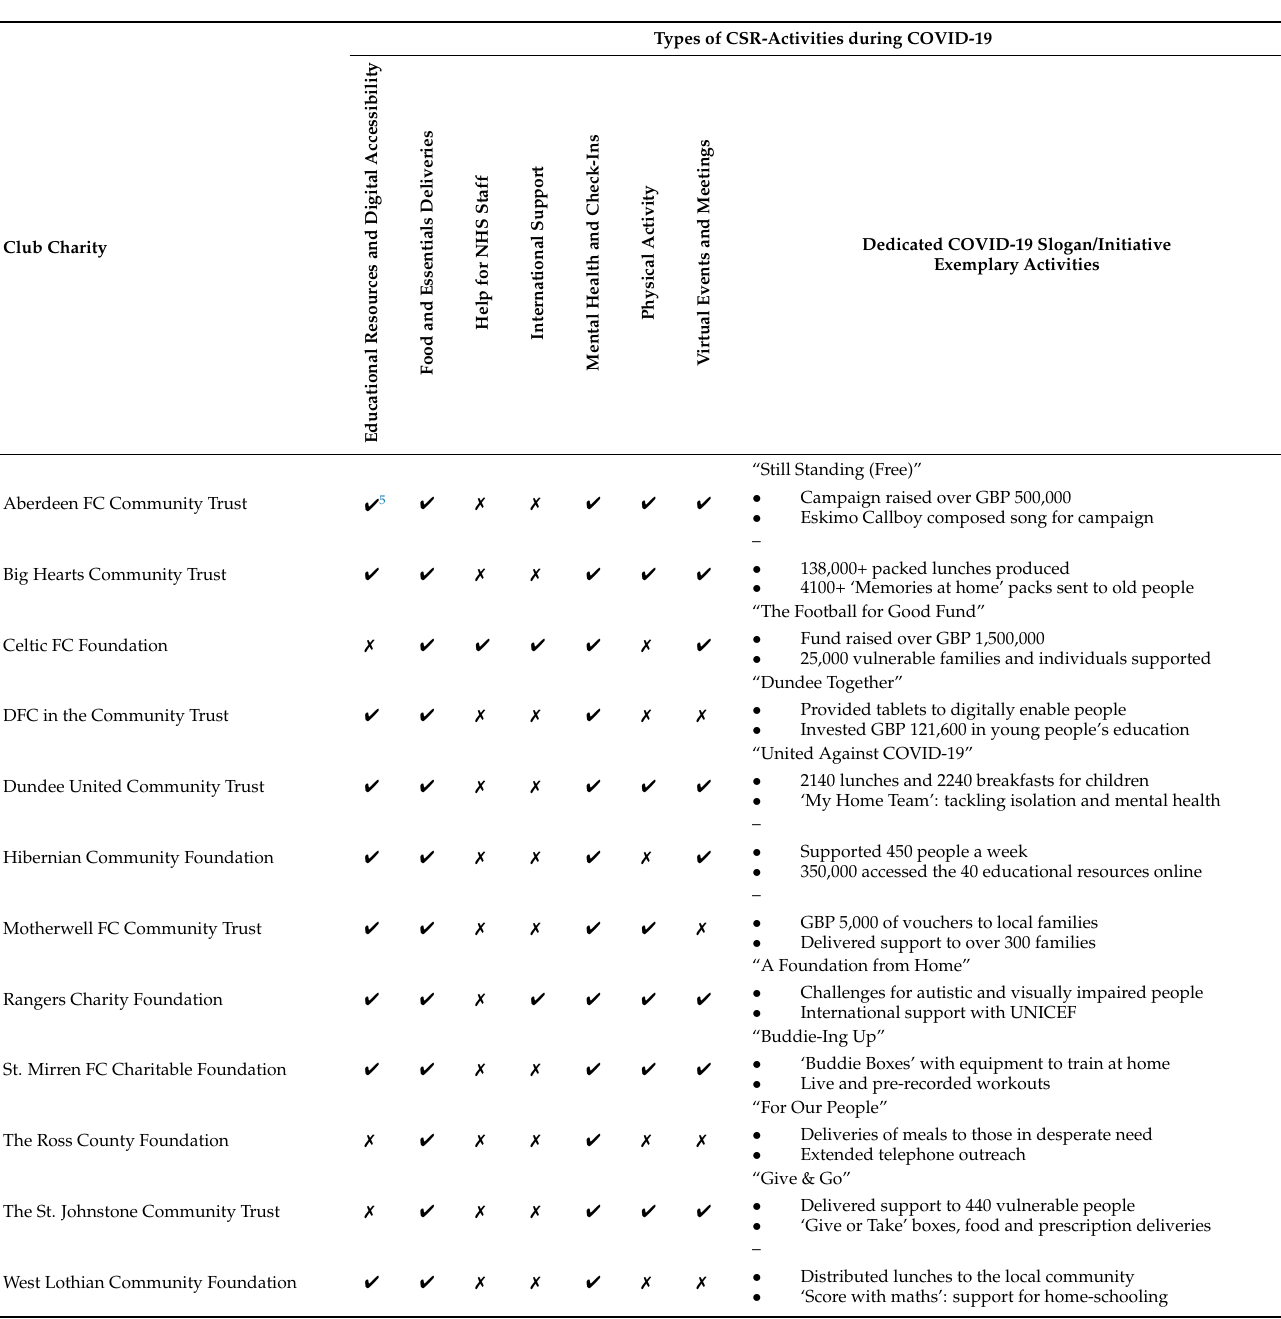
Table 5. COVID-19 related CSR activities (based on SPFL Trust, 2021 and club/charity